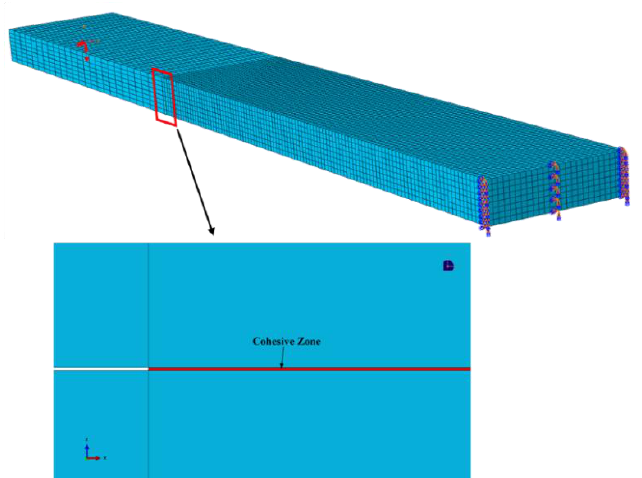
Figure 8. The specimen’s geometry and experiment conditions.